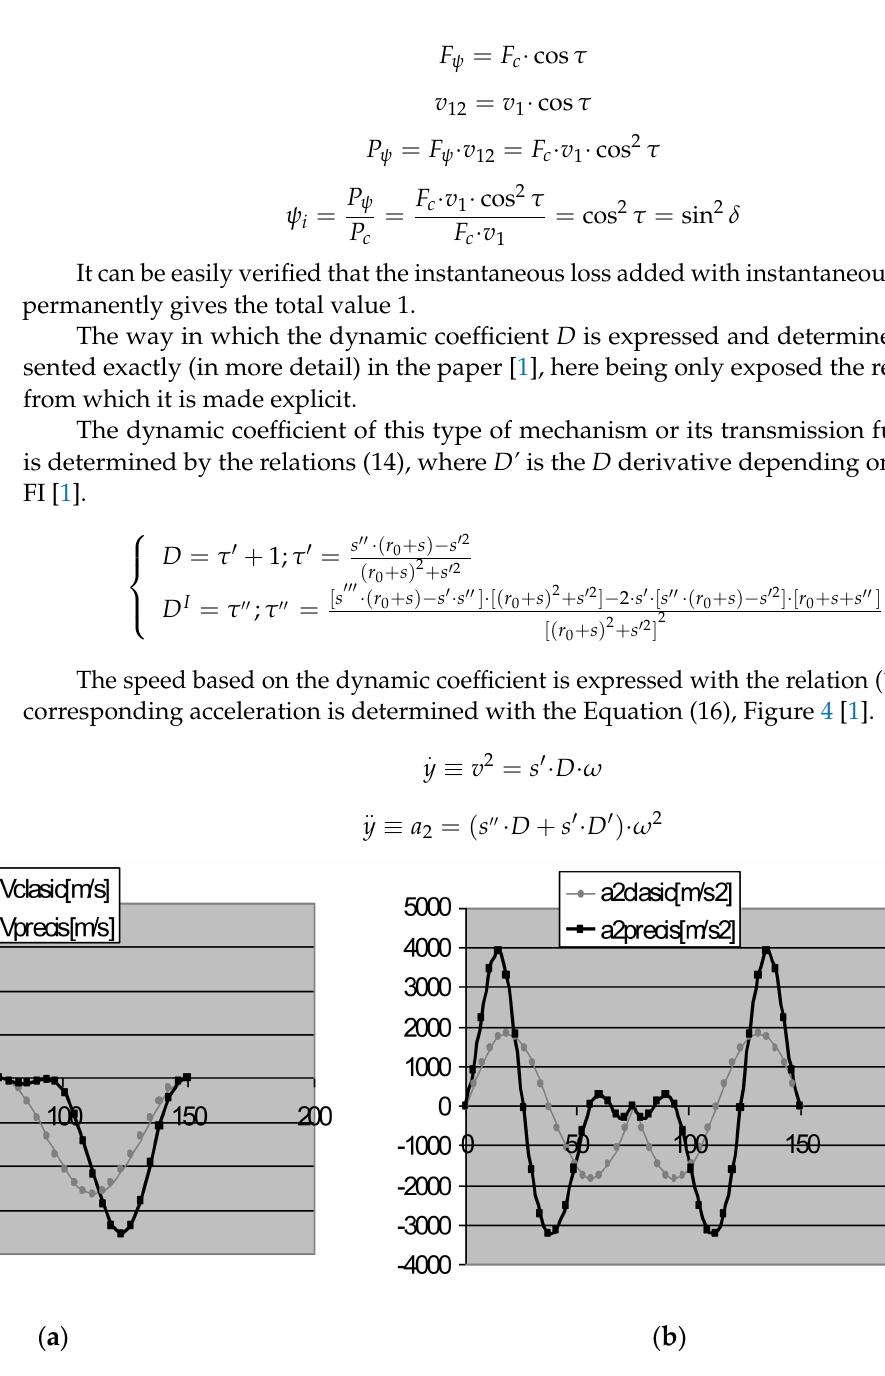
Figure 4. Comparison between classical kinematics and proposed kinematics in this paper. ( a )-speeds and ( b )-accelerations of the